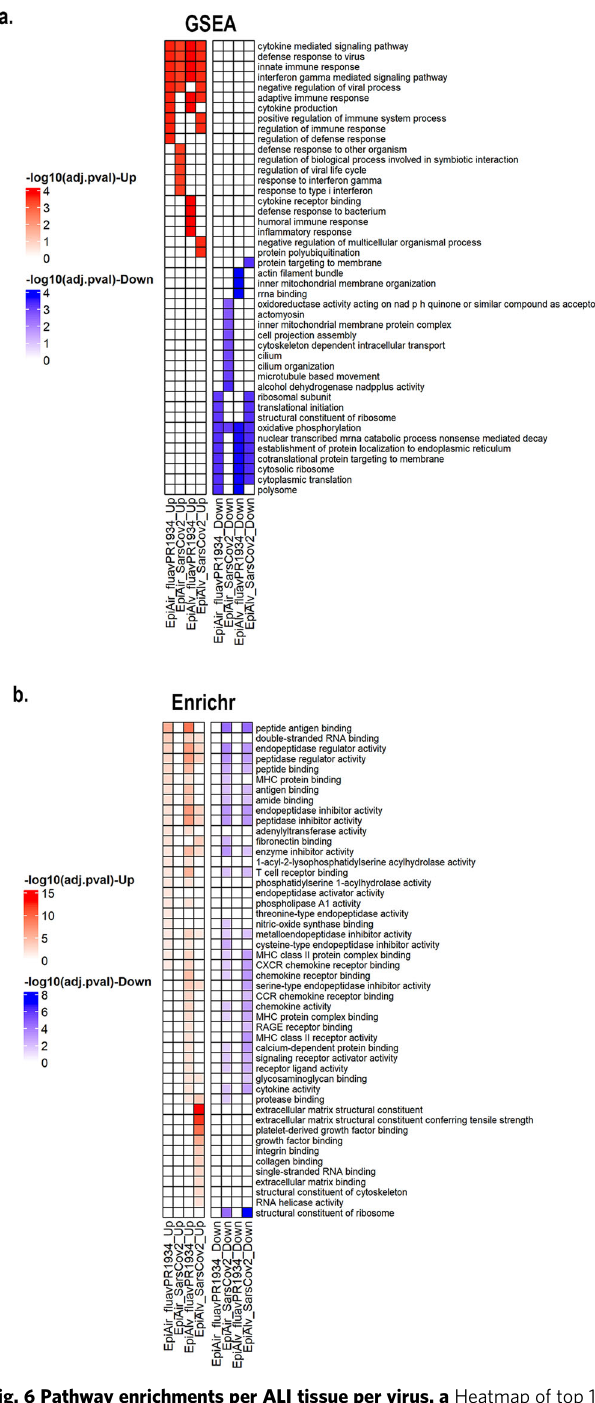
Fig. 6 Pathway enrichments per ALI tissue per virus. a Heatmap of top 10 up- (red) or down-regulated (blue) pathways by GSEA, expressed as -log10 adjusted p value; ( b ) heatmap of top 20 differentially regulated pathways between the four conditions by Enrichr analysis, expressed as -log10 adjusted p